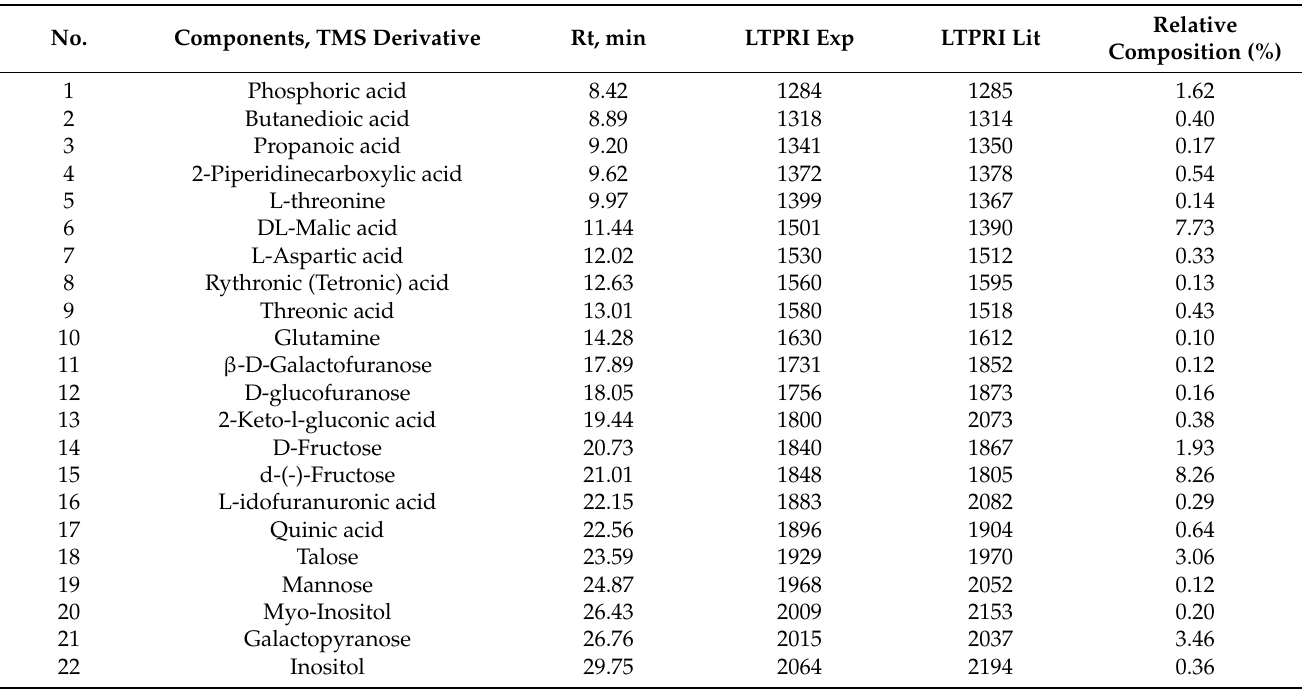
Table 5. Chemical composition of 70% ethanolic extract of young barley grass